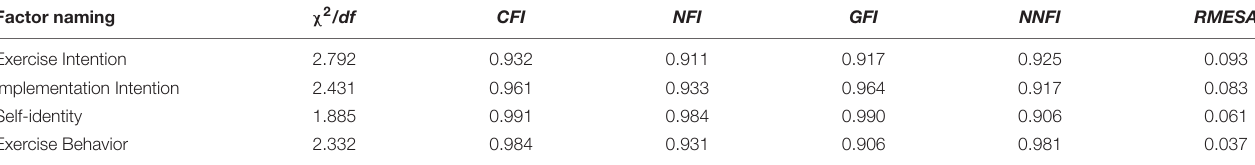
TABLE 2 | Results of confirmatory factor